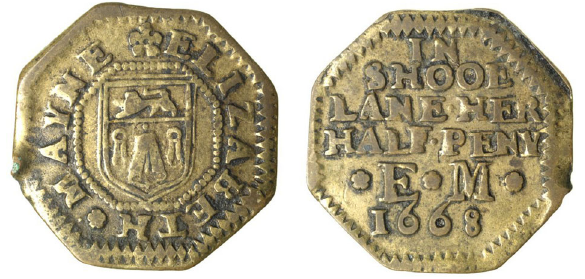
Fig. 4 Trade tokens issued by Elizabeth Mayne, London 1668. This fi gure is not covered by the Creative Commons Attribution 4.0 International